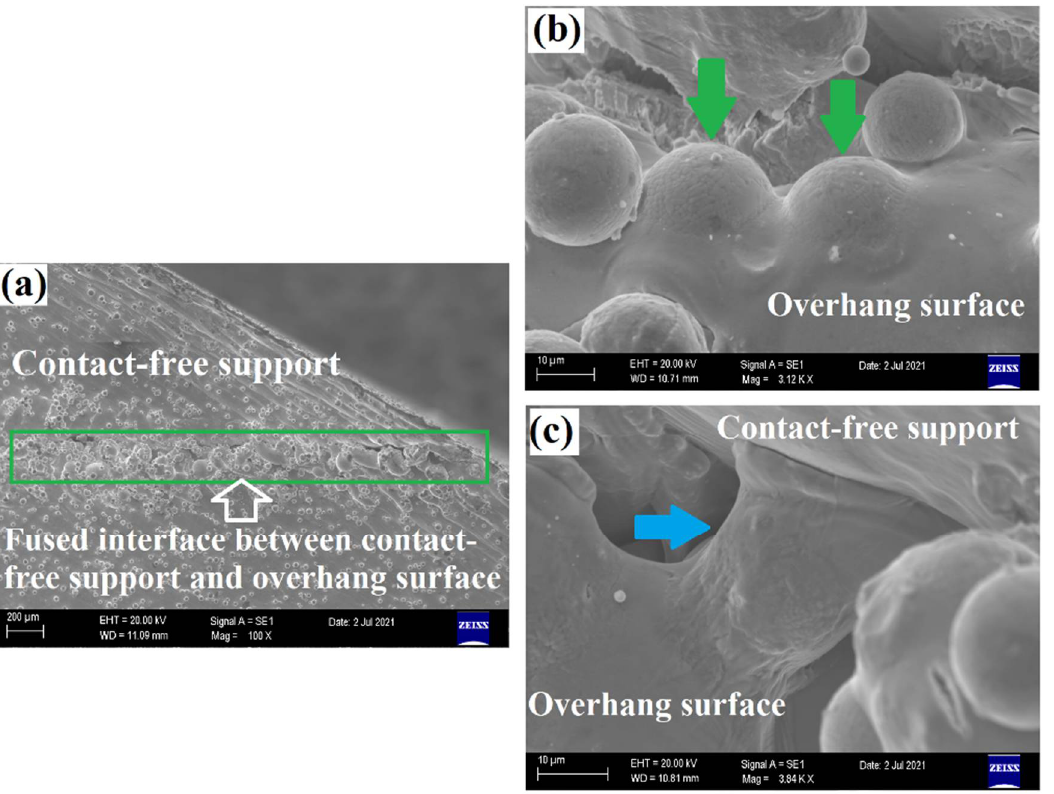
Figure 4. SEM images obtained from the side view of CS-30°-125 μm: ( a ) Macro view of region of fusion, ( b ) Partially melted particles on the melt pool surface, and ( c ) A particle created a bonding between overhang surface and contact-free support structure.